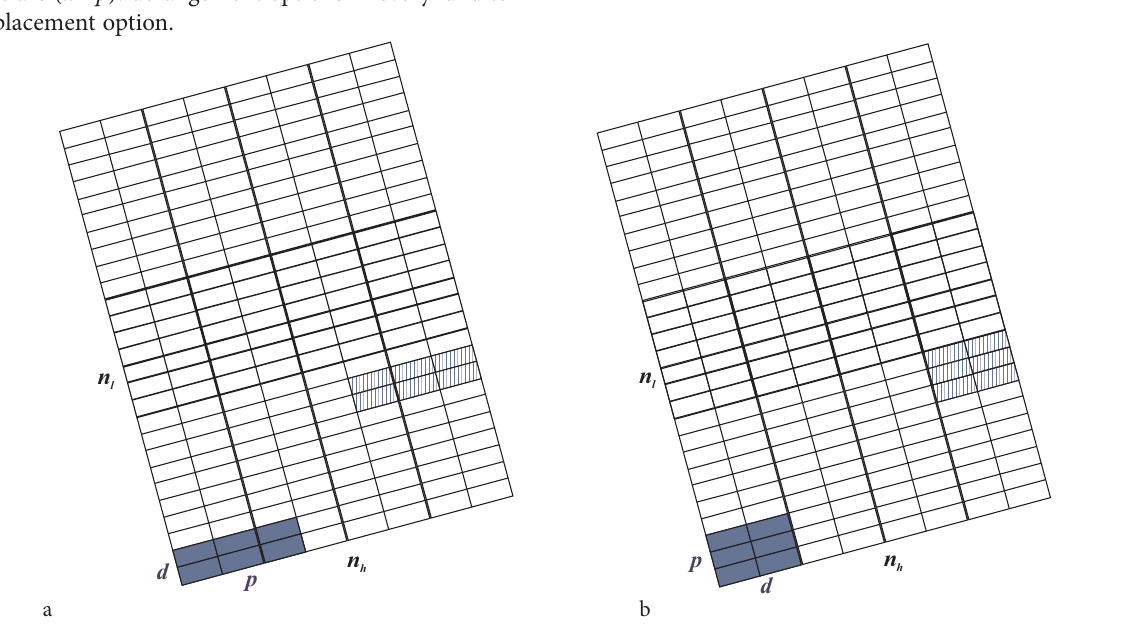
Figure 7. Consolidated land plots placement options at the land mass boundary